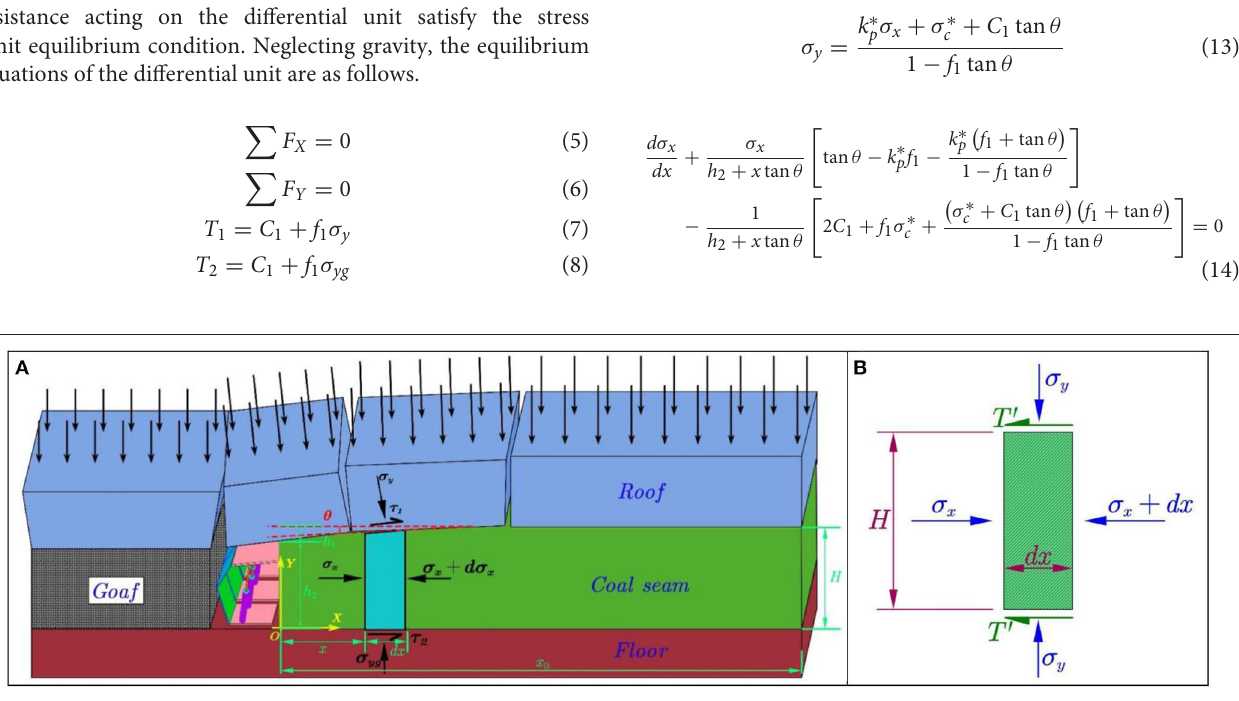
Frontiers in Physics |